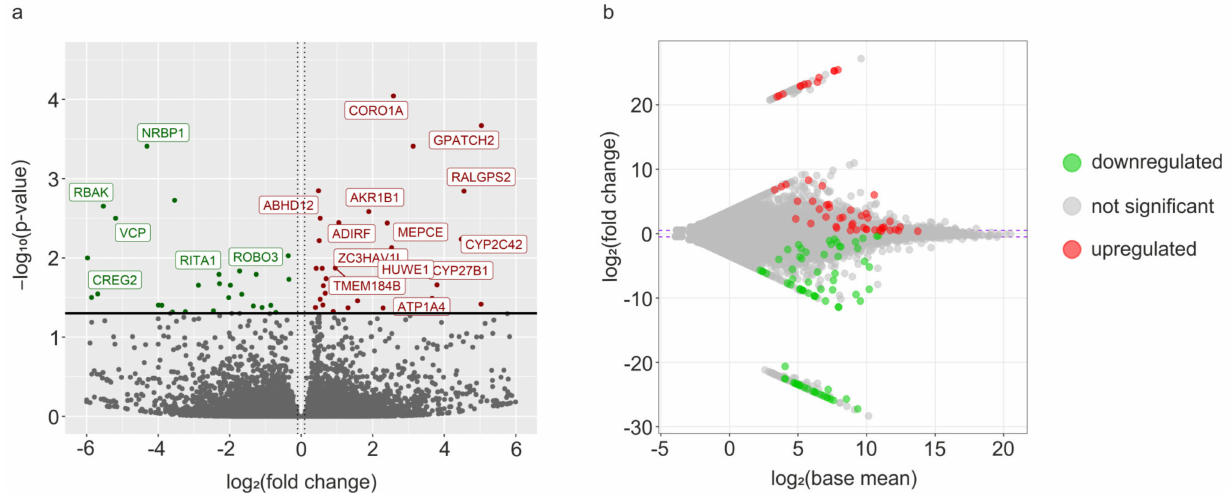
Figure 1. Transcriptome-wide RNA-Seq analysis and expression profiles of the differentially ex- pressed genes (DEGs) for RTX-treated and control libraries. ( a ) The volcano plot depicts log2FC plotted against log-normalized p values. The horizontal line indicates a negative logarithmic adjusted p value (0.05) cut-off. Dotted double vertical lines indicate cut-off values of logFC. The square brackets comprise the symbols of the selected genes with high functional significance. ( b ) MA plot presents the logarithmic scale of the fold changes in the Y axis and the normalized expression count values in the X axis. Two horizontal dotted lines refer to the cut value of log2FC >1 and < − 1. The red color illustrates upregulated DEGs; the green color represents downregulated DEGs; grey dots are nonsignificant transcripts according to DESeq2